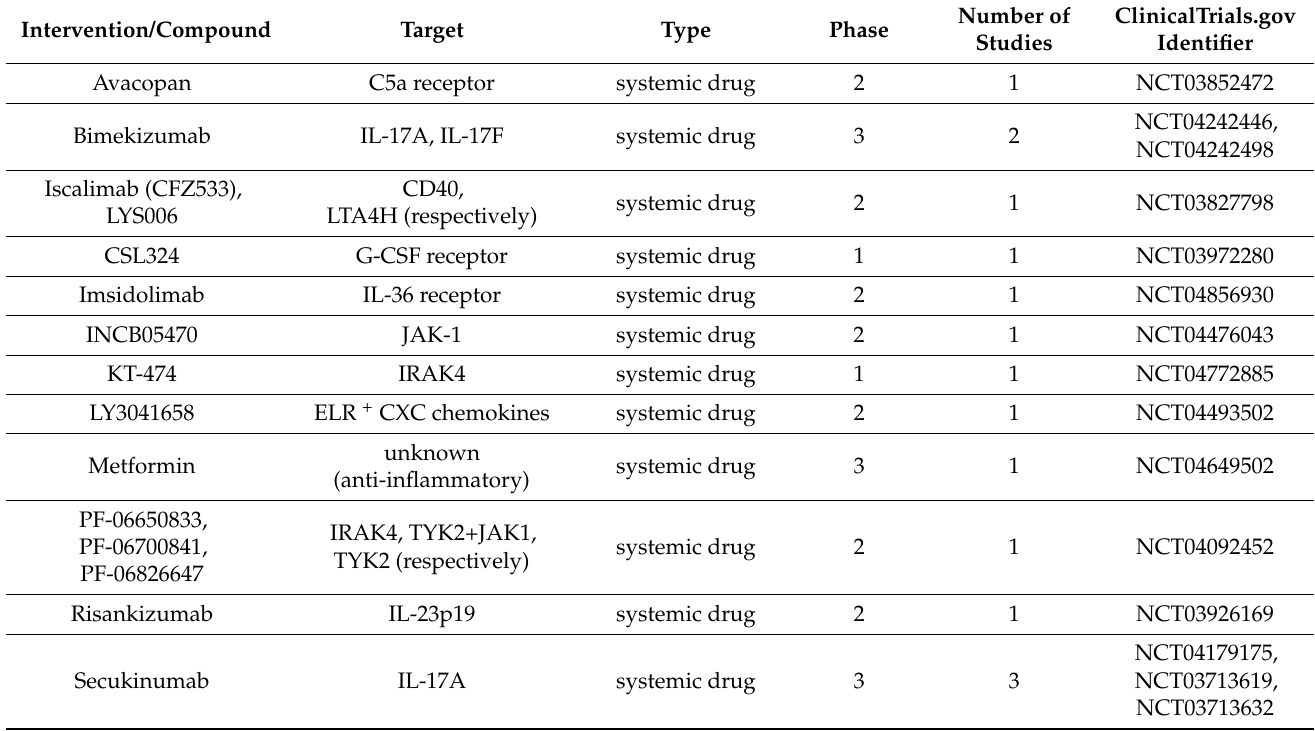
Table 2. Ongoing and upcoming interventional trials on